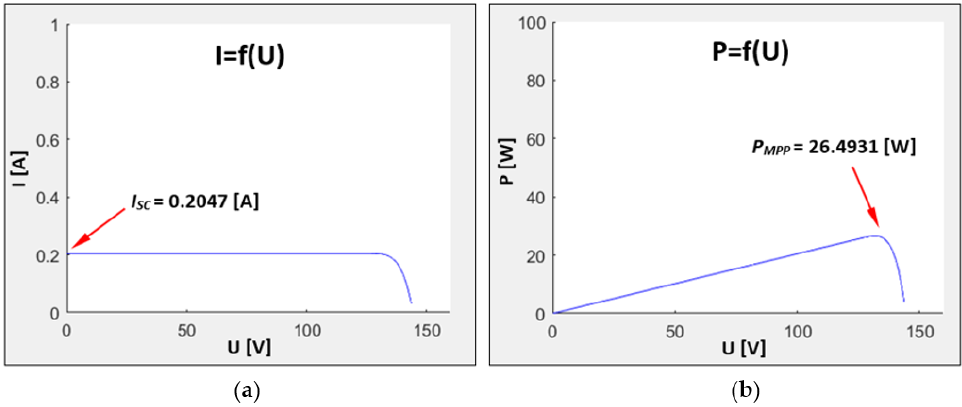
Figure 6. Simulation results for irradiance 300 W/m 2 and temperature 21 °C for modeled CX-75/200 module: ( a ) current–voltage characteristic curve I = f(U); ( b ) power diagram P = f(U).